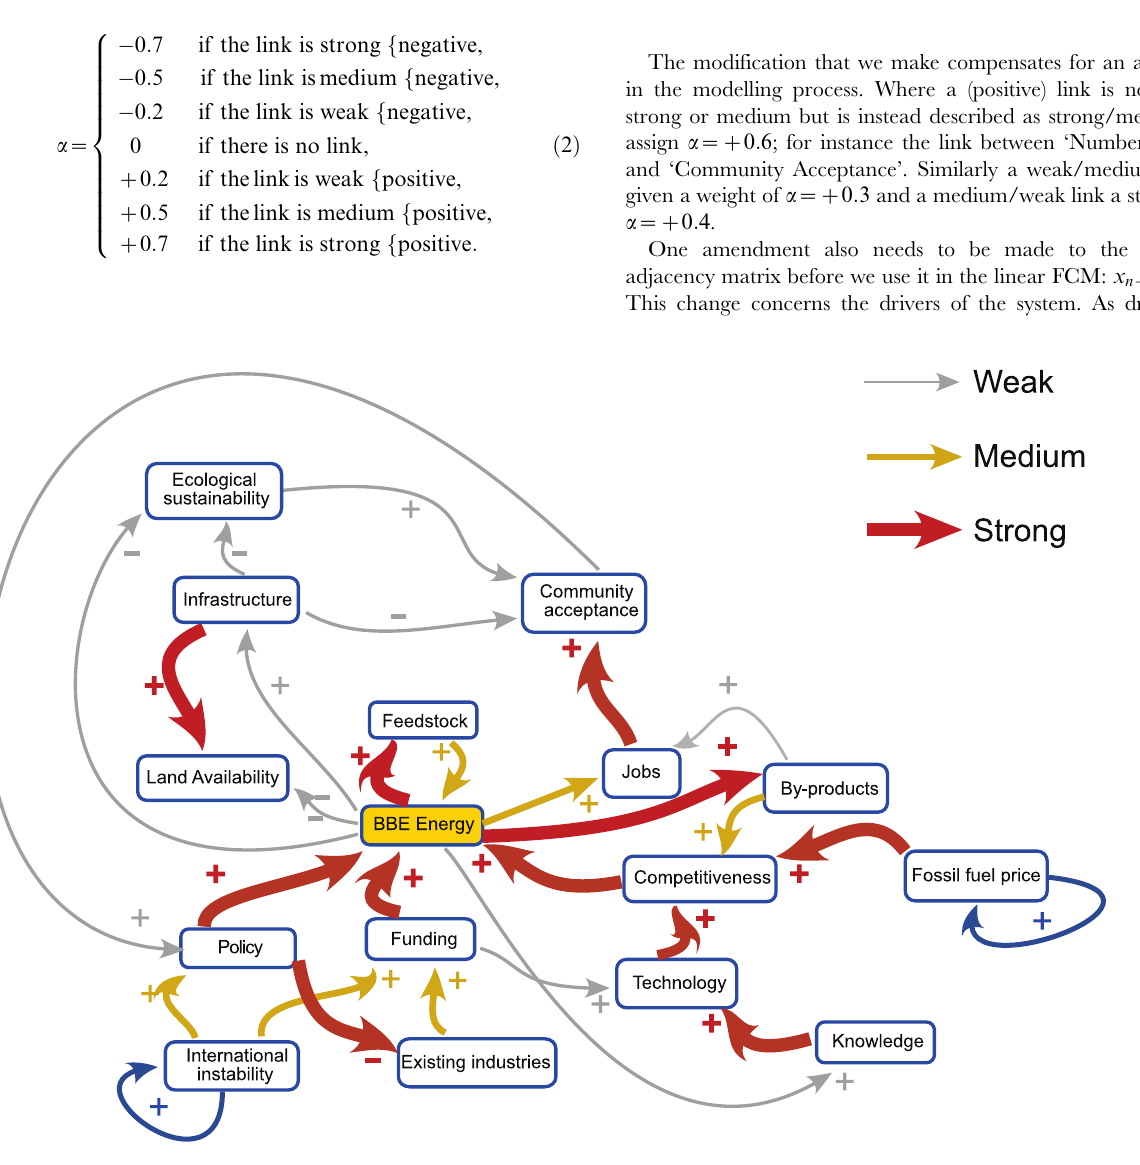
Figure 1. Humber region bio-based economy FCM from first workshop. Thickness of the links denotes the strength of the influence. doi:10.1371/journal.pone.0078319.g001 PLOS ONE |